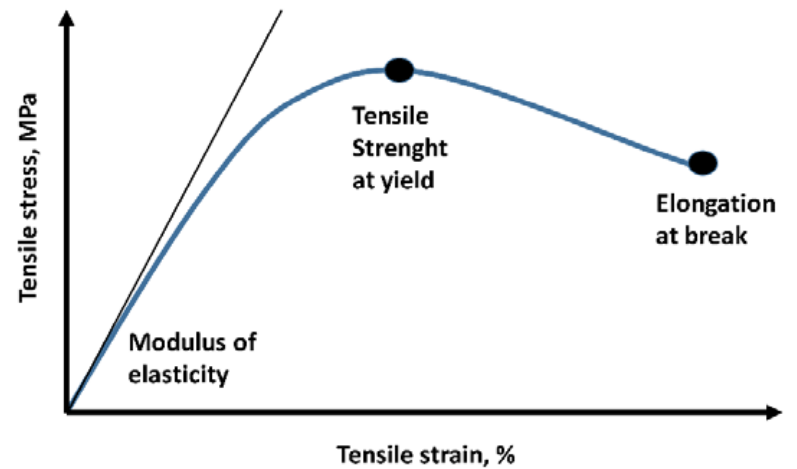
Figure 14. Mechanical parameters considered for the evaluation of edible films/coatings.